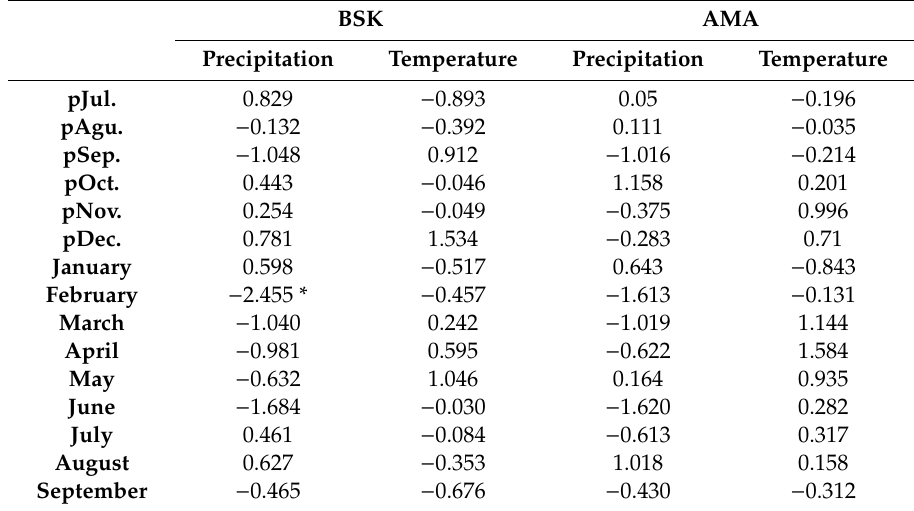
Table 4. Di ff erences in correlation coe ffi cients for the two tree-ring chronologies and climatic data assessed by u test values.